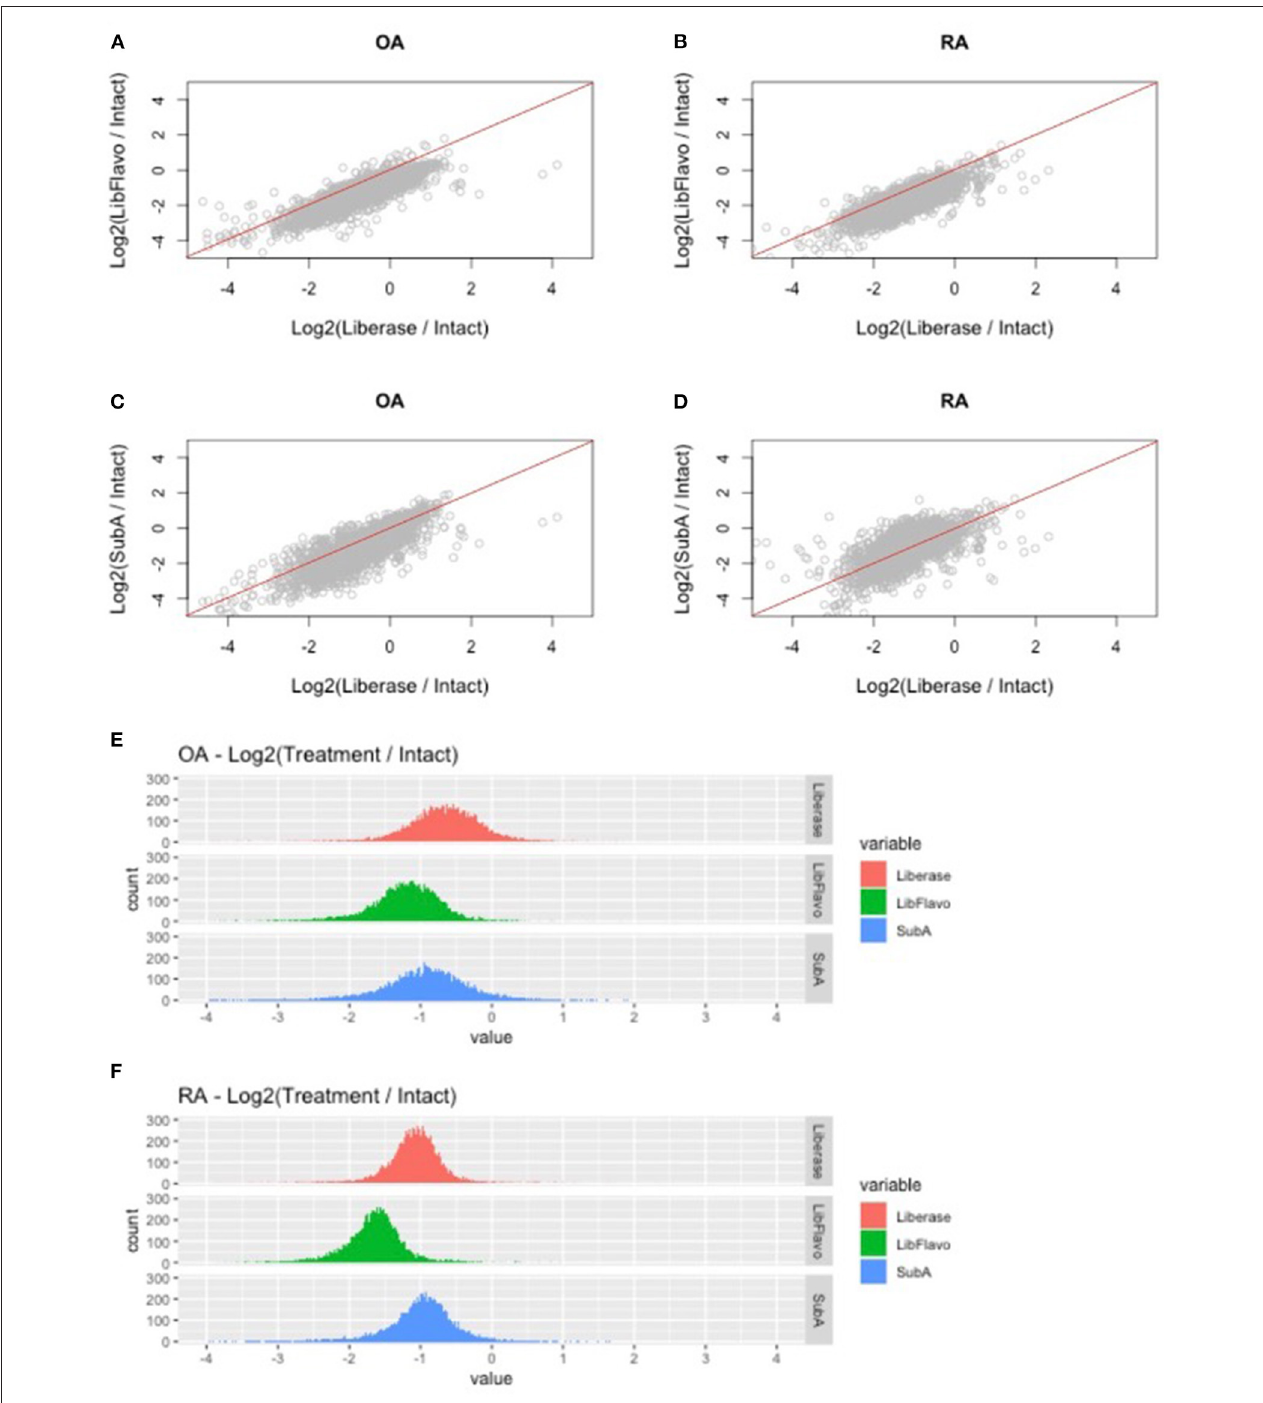
FIGURE 3 | RNAseq fold change comparison of gene expression using different disaggregation protocols. (A–D) Relative changes in each gene for the 3 protocols compared to intact are shown for the top 50% of expressed genes. Genes that are represented below the line are induced more in Lib compared with Lib + Flavo or SubA. (E,F) Distribution of gene expression changes in each protocol for RA and OA. Histograms are colored by disaggregation protocol. A log2 scale is used on the x-axis, so “zero” represents identical expression compared with intact. Points to the right represent induced genes.